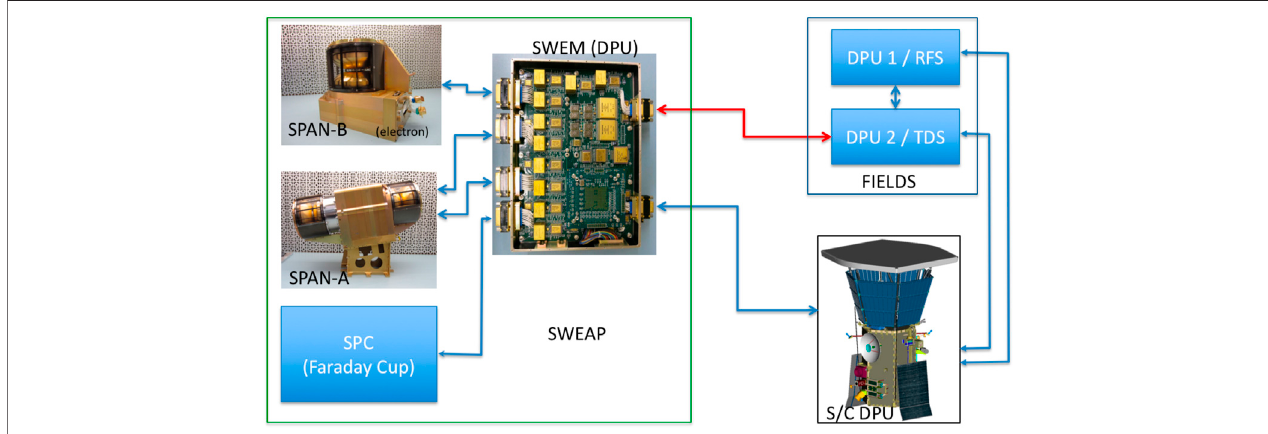
FIGURE 1 | The SWEAP/FIELDS interface on PSP : the Wave-Particle Correlator (WPC). The additional hardware (mass resource) consists of a single cable (red) that allows the SWEAP and FIELDS instruments to communicate to each other without the need to pass through the spacecraft interface. Wires in this cable conduct a 200 ns long particle pulse signal every time a particle is detected in a SPAN. From Verniero et al.